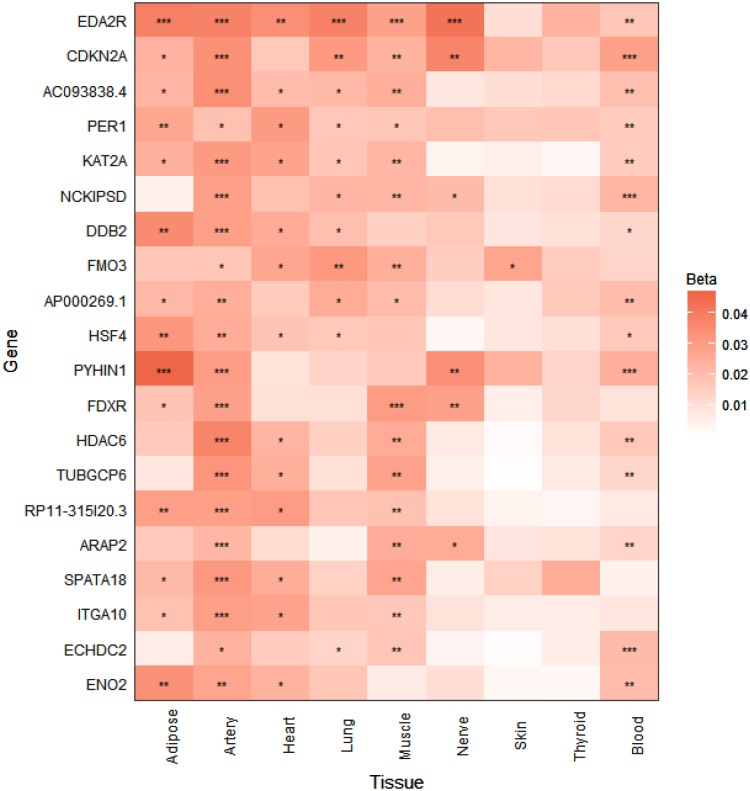
p16Ink4a expression is significantly elevated with age in multiple tissues in humans. Expression heatmap of the top 20 human genes showing increased expression with age across 9 tissues (subcutaneous adipose, tibial artery, left ventricle heart, lung, skeletal muscle, tibial nerve, skin from sun exposed lower leg, thyroid, and whole blood) analyzed by RNA-seq of the GTEx consortium. CDKN2A (p16Ink4a) exhibits significant increases in expression in 6 tissues with age. Genes are ranked from top to bottom according to number of tissues that show significant age-dependent upregulation. ∗P < 0.05; ∗∗P < 0.01; ∗∗∗P < 0.001 (FDR adjusted p-values). Beta represents the linear regression coefficient used to determine age-dependent expression change, with higher values indicating higher expression with age.